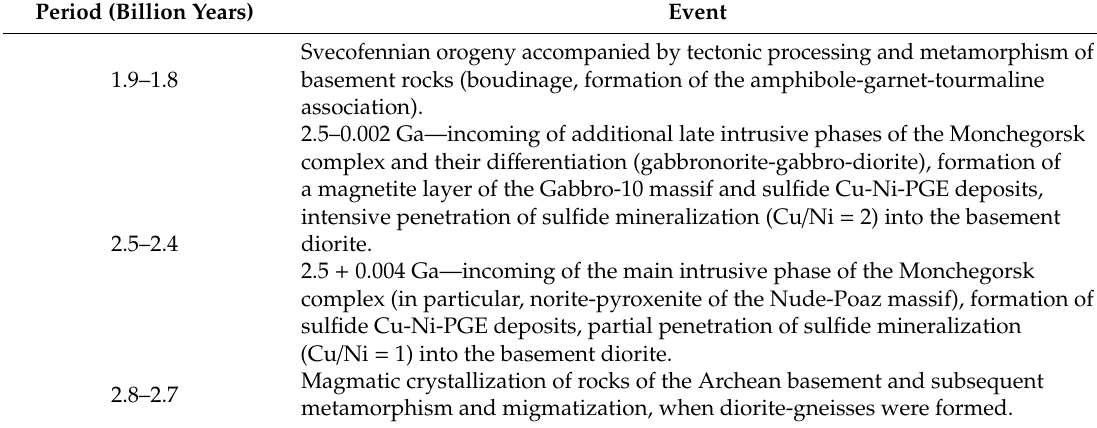
Table 8. The sequence of major geological events in the interval 2.8-1.8 Ga in the region of the current position of the Monchegorsk